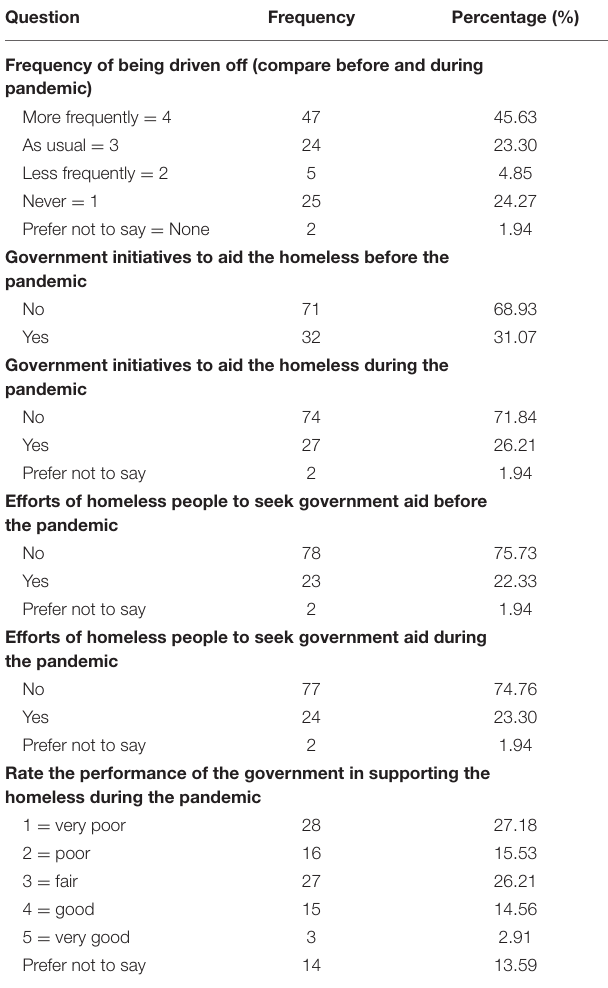
TABLE 3 | Action of the government toward the homeless before and during the pandemic ( n =